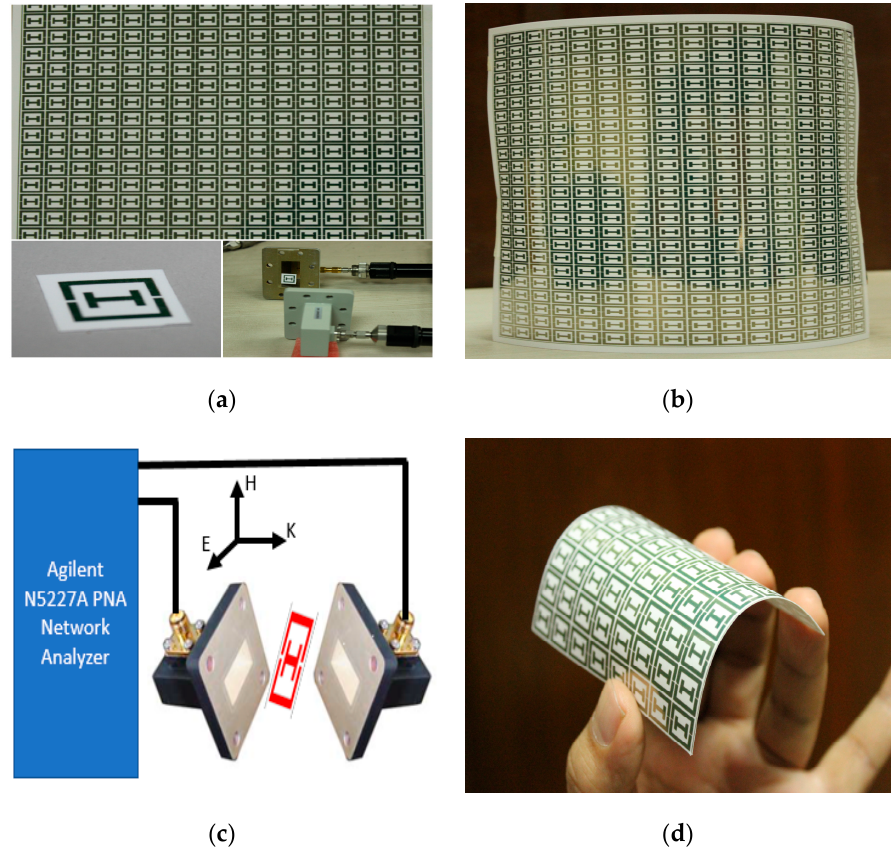
Figure 3. ( a ) Inkjet-printed metamaterial with waveguide port; ( b ) array of the prototype; ( c ) measurement setup; ( d ) flexible metamaterial prototype.